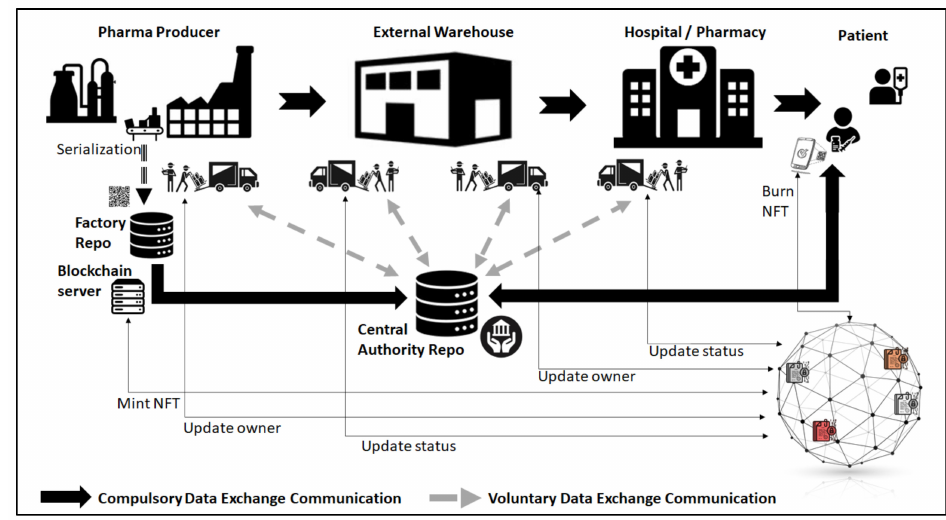
Figure 8. Track and trace process with a central authority and blockchain serialization.